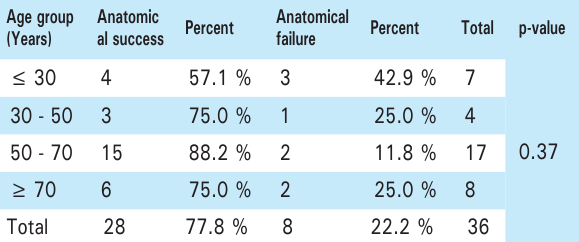
Table 8. Correlation of age with anatomic success of the macular hole surgery at the last